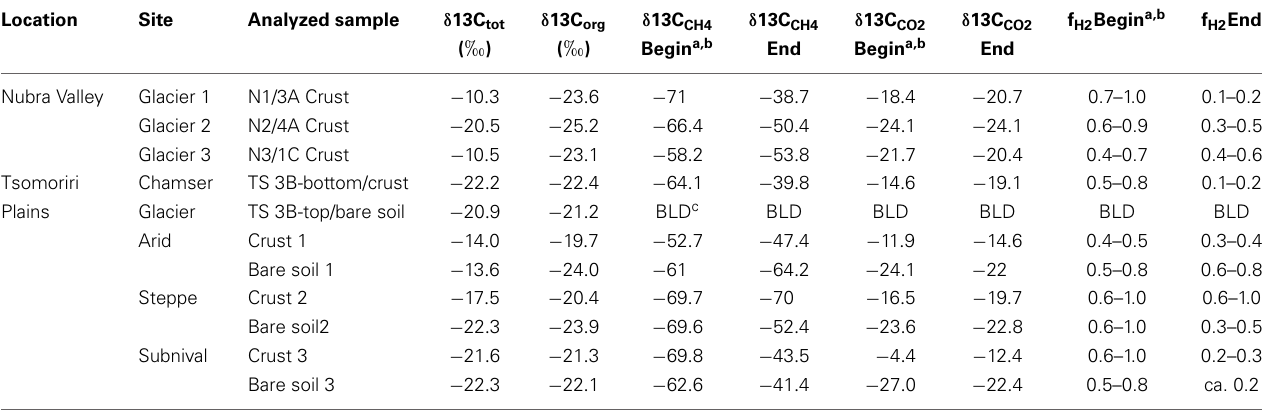
a Means of the 3 technical replicates. b “Begin” and “end” refer to the first and last measurements. c BLD, below the limit of